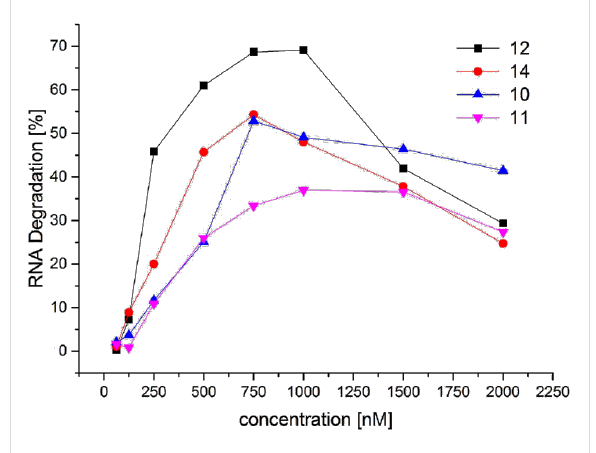
Figure 4: Cleavage of RNA substrates 15 , 16 , and 17 by their matching conjugates as a function of conjugate concentration (150 nM substrate, 62.5–2000 nM conjugate, 50 mM Tris-HCl, pH 8, 37 °C, 20 h). Data points are connected by lines for the sake of clarity.